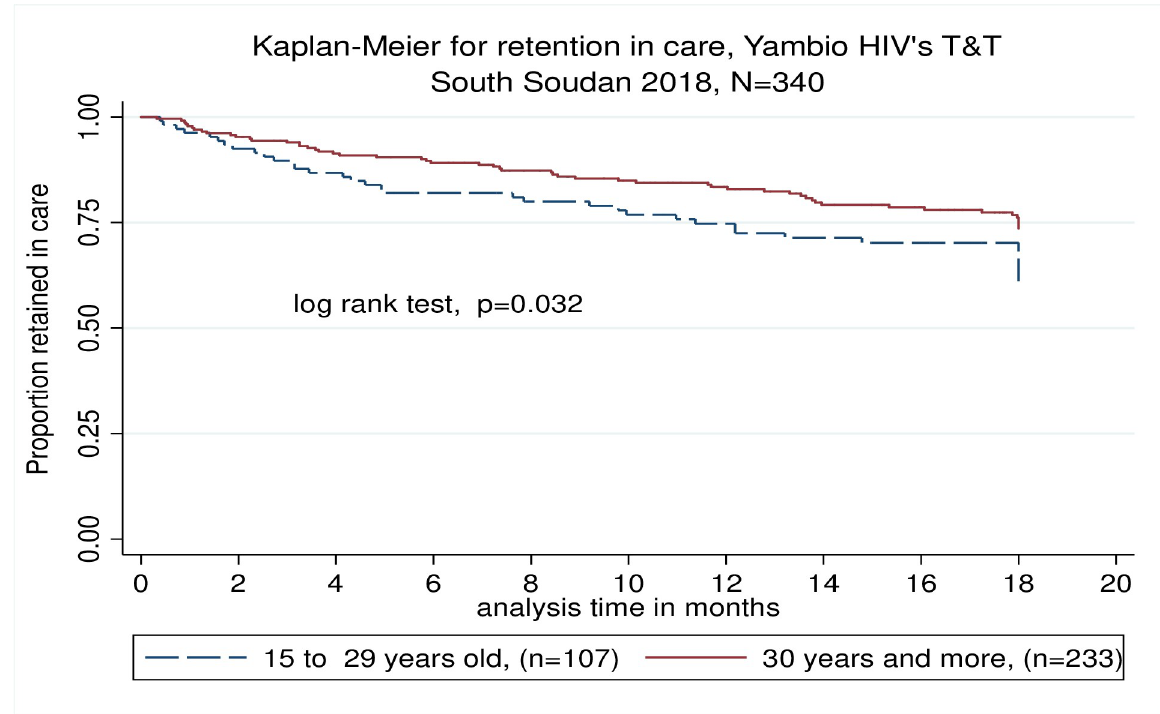
Fig 4. Kaplan Meier estimated RIC at 12 and 18 months.